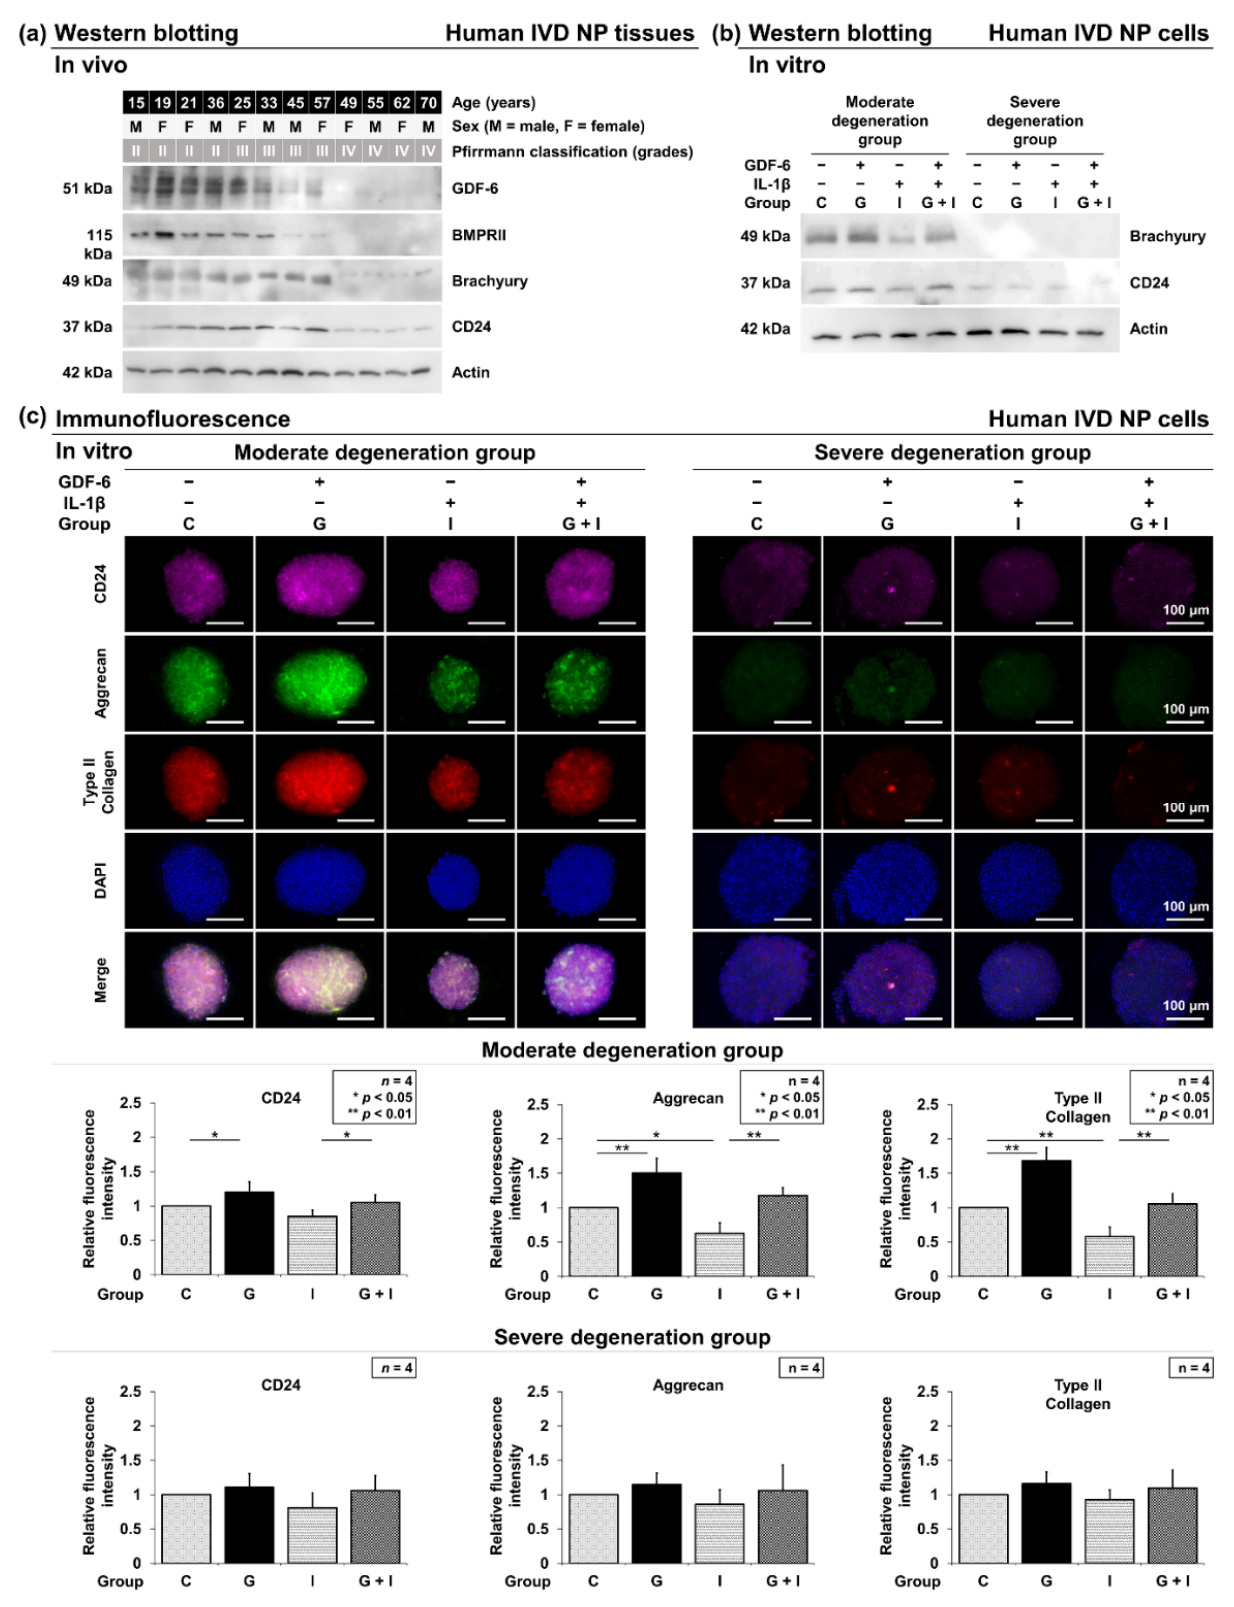
Figure 2. ( a ) Variation in growth differentiation factor-6 (GDF-6) levels with aging and intervertebral disc (IVD) degeneration. Levels of GDF-6, bone morphogenetic protein receptor type II